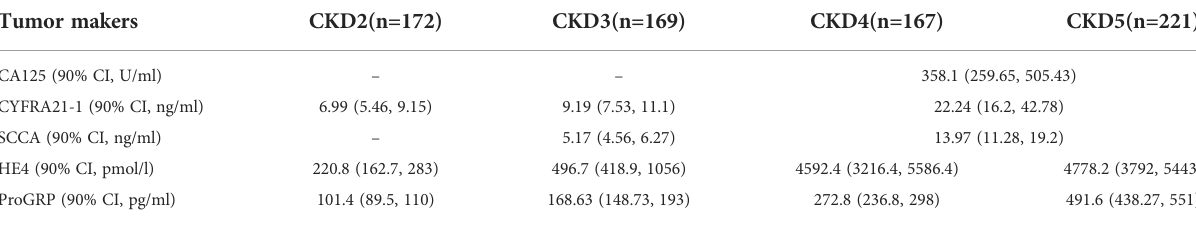
TABLE 5 The reference upper limit de fi ned by non-parametric method (P 97.5 ) in patients with different stages of CKD. Tumor makers